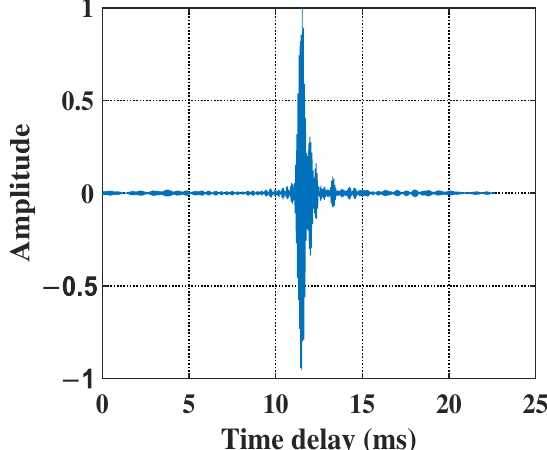
Figure 12. The CIR of the experiment channel.